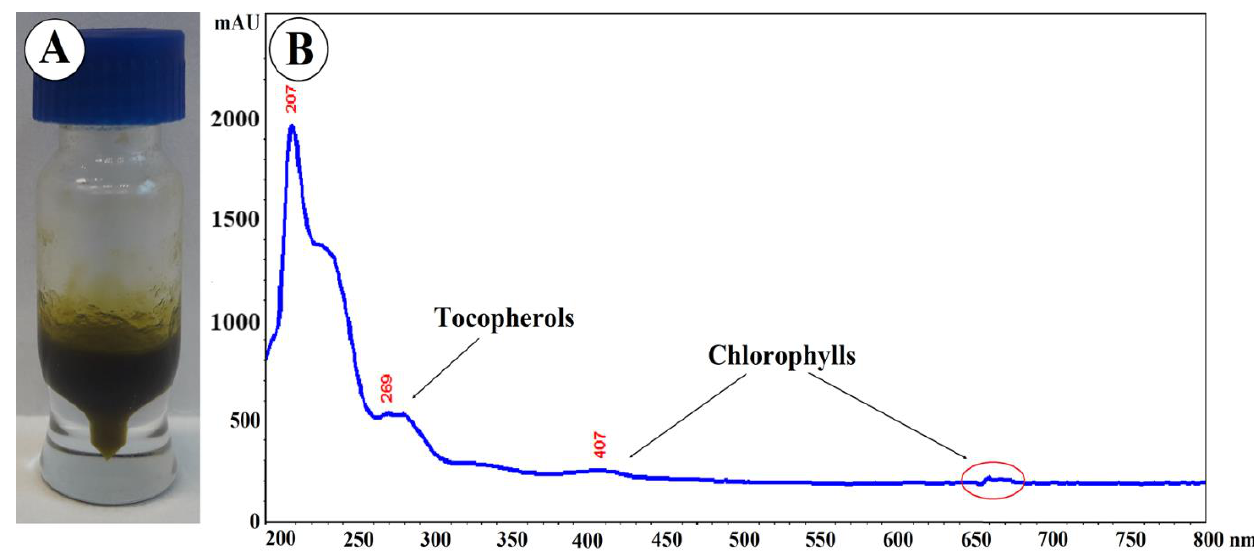
Figure 8. ( A ) Photography and ( B ) UV–VIS spectroscopic fingerprint of Eleutherococcus senticosus fruit oil. Table 3. Content of fatty acids (% w/w ± SD) in Eleutherococcus senticosus seed oil ( n = 3) (RT—retention time,